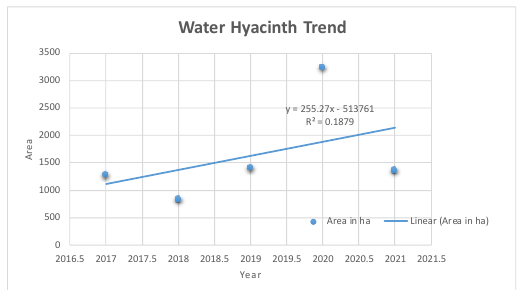
Figure 11: Shows the areas coverage values as well as a trend line